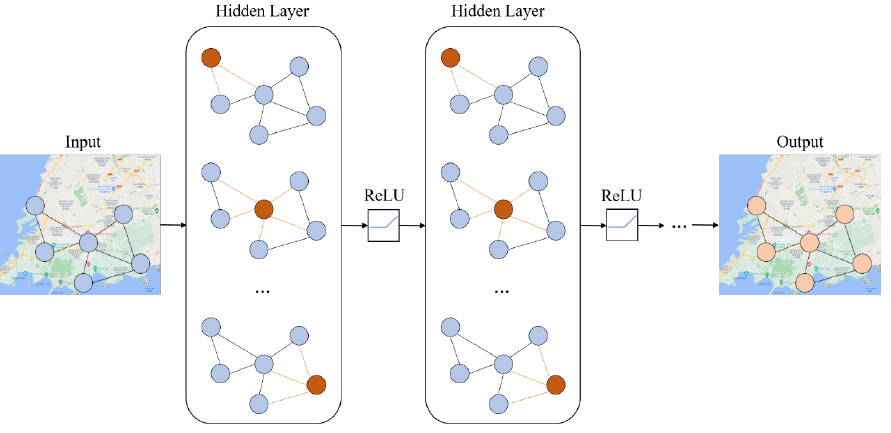
Figure 4. The structure of multi layers GCN.